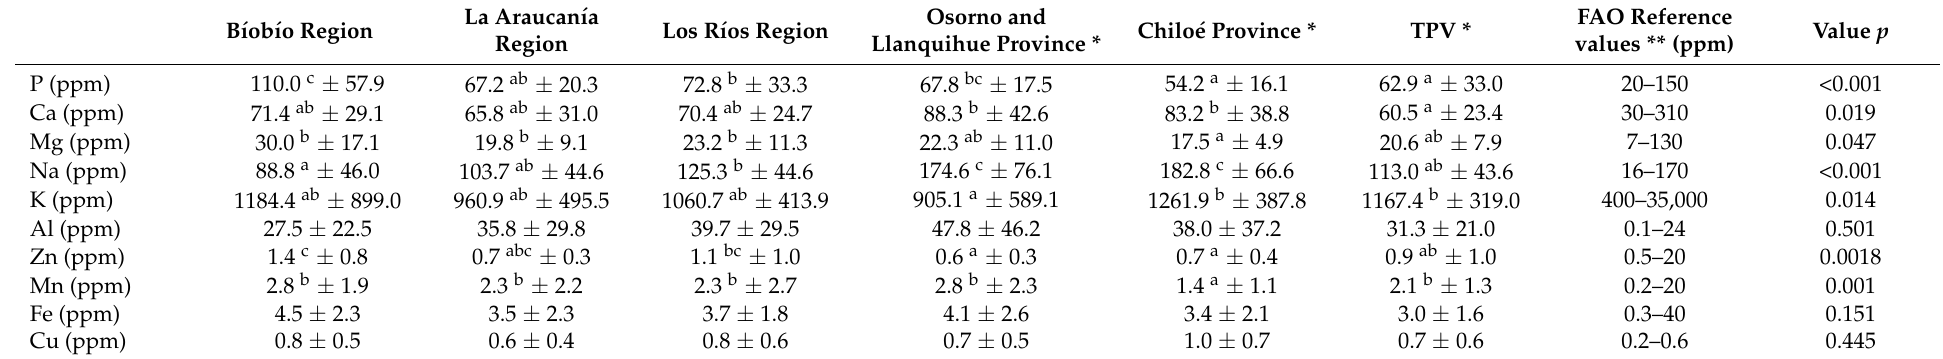
Table 6. Mineral content of honeys produced in Chile’s central-southern